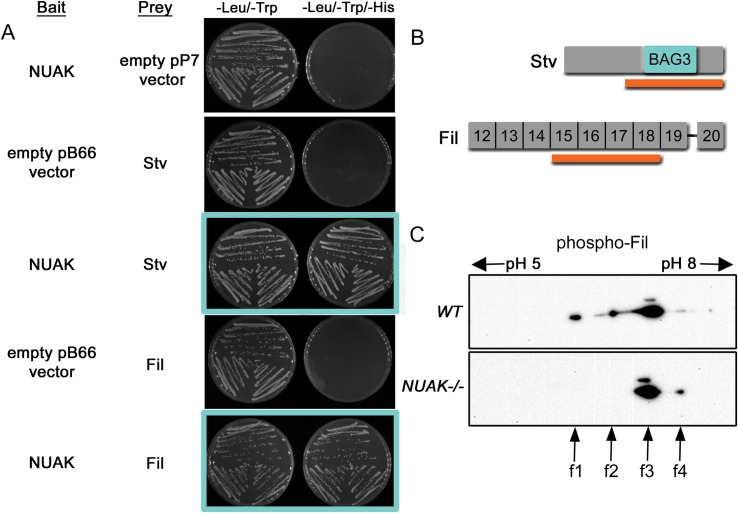
Stv/BAG-3 and Fil physically interact with NUAK.(A) Confirmation of one-by-one Y2H interaction results using NUAK as a bait with Stv and Fil as prey proteins. The selective medium lacking tryptophan and leucine is used as a positive control to verify the presence of the bait and prey plasmids. Three independent yeast clones were streaked onto plates lacking histidine to verify NUAK protein interactions with Stv or Fil (blue boxes). (B) Schematic of Drosophila Stv and the C-terminal region of Fil isoforms (Ig domains 12–20). The orange bar represents the selected interaction domain of NUAK with the conserved BAG3 domain of Stv and Ig domains 15–18 in Fil. (C) 2D gel Western blot of WT or NUAK-/- muscle carcasses probed with anti-Fil. Two forms of phosphorylated Fil in WT muscle (f1 and f2) disappear upon loss of NUAK. A predominant spot likely corresponding to non-phosphorylated Fil (f3) is present in both WT and NUAK-/- muscle tissue, with f4 present as a possible minor form.